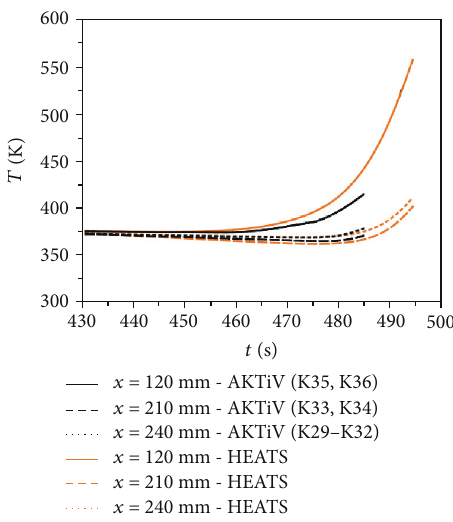
Figure 27: AKTiV cooling e ffi ciency for T